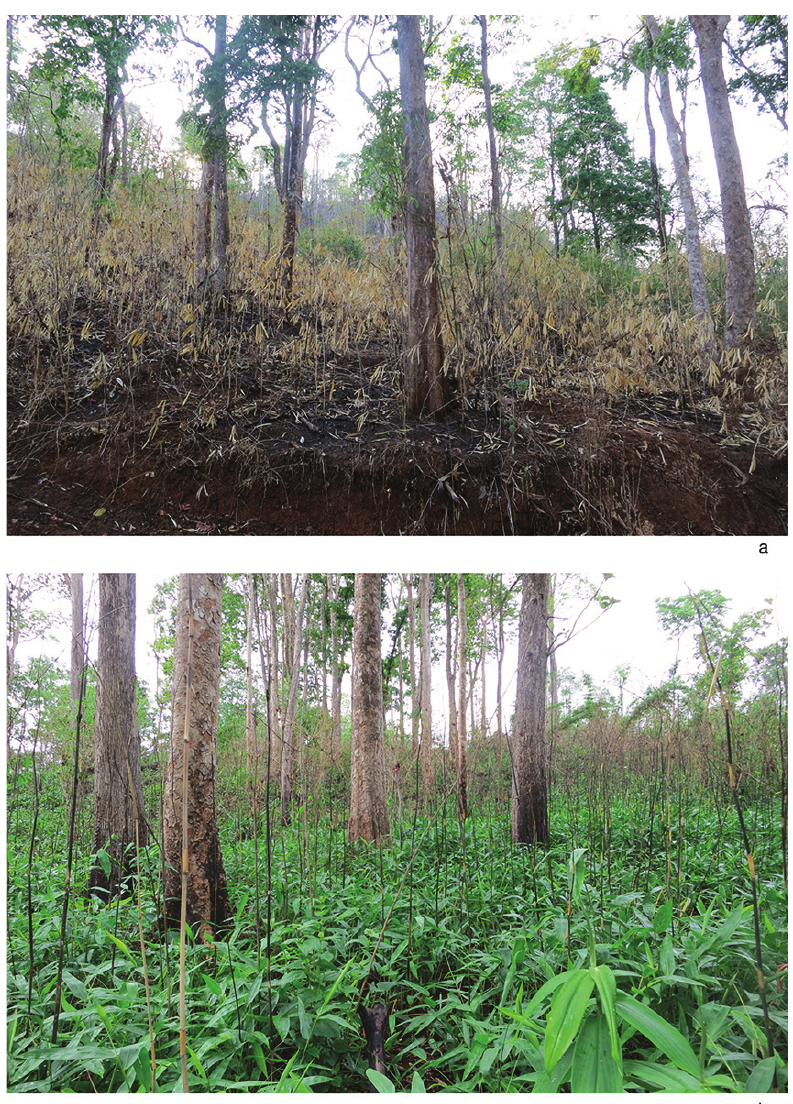
Figure 1. Mating sites of A. rufipes . ( a ) On 24 April 2014, about 5 weeks before the